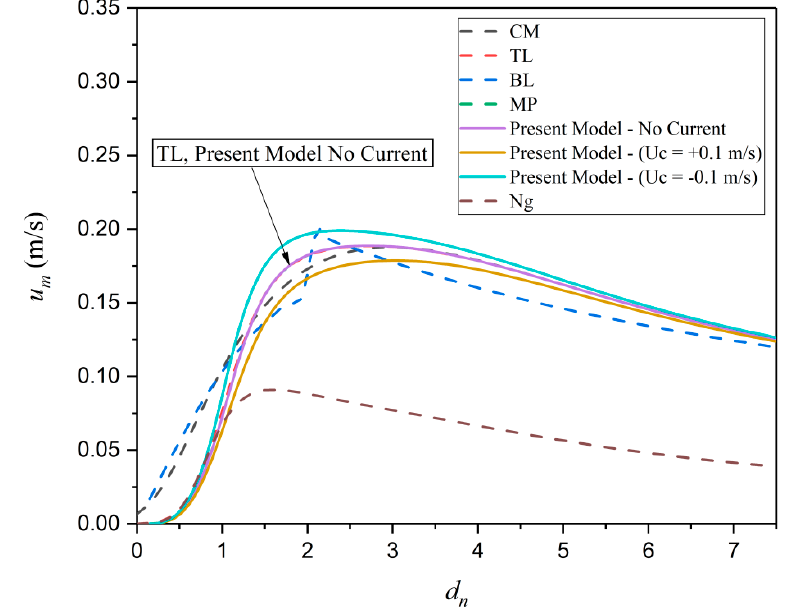
Figure 10. Water velocity ( y = − ( h+ 0.5 d ) versus dimensionless mud thickness, T = 1.4 s; h =0.0381 m; ν w =0.0000026 m 2 /s; ν m =0.0026 m 2 /s; ρ w =859.3 kg/m 3 ; ρ m =1504 kg/m 3.